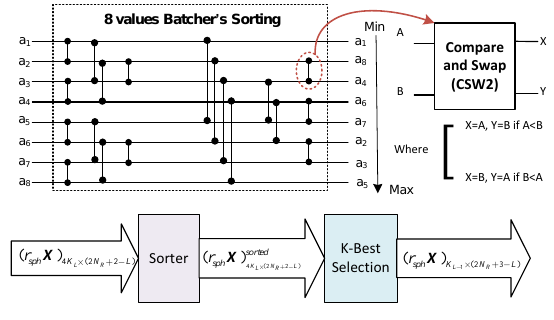
Figure 10. Detailed hardware implementation of an